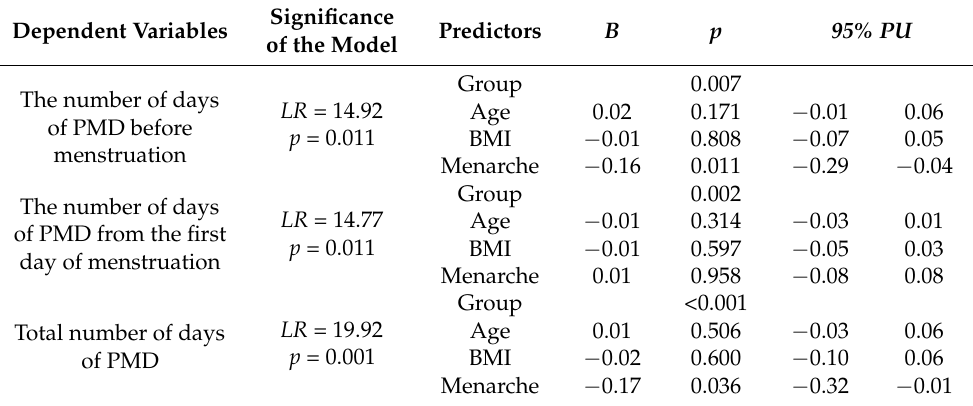
Table 4. Multiple linear regression analysis of the predictors: group, age, BMI, age of menarche, and duration of PMD symptoms associated with menstruation.